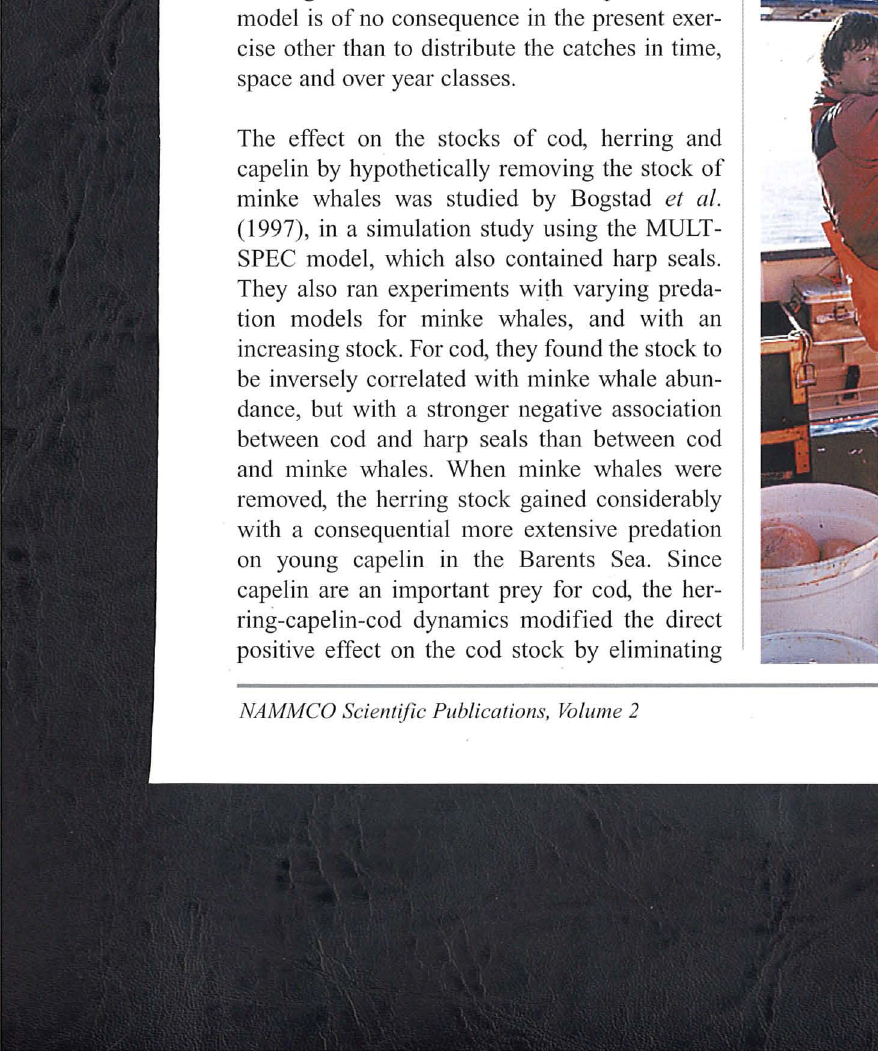
Fig.} Although minke whales feed mainly on invertebrates and small fish, they occasionally take larger items such as this